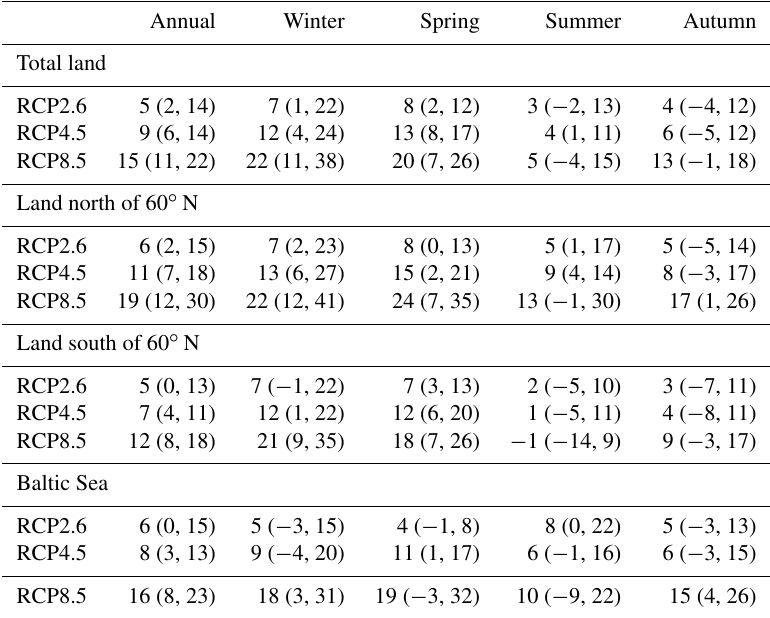
Table 13. Relative precipitation changes (percent) between 1976–2005 and 2069–2098, averaged over each season, and the annual mean over the Baltic Sea catchment area and over the Baltic Sea calculated from nine dynamically downscaled ESM simulations. In addition to the ensemble mean change, the 5th and 95th percentiles indicating the ensemble spread are listed (in parentheses). Data source: Gröger et al., 2021b.